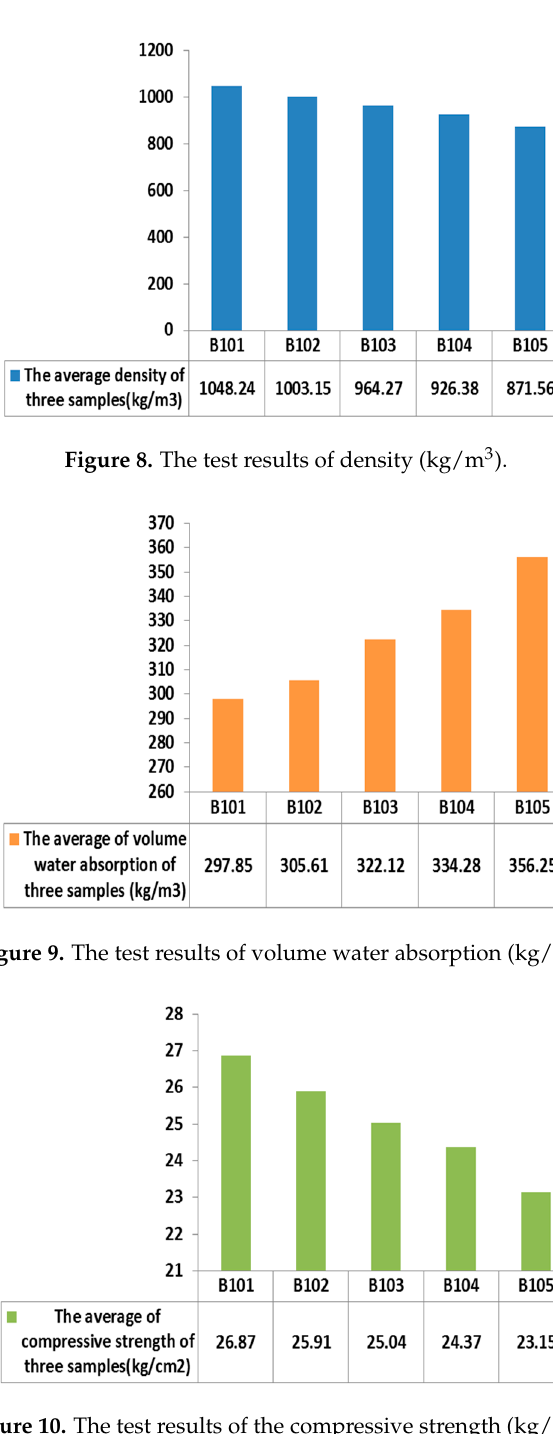
Figure 10. The test results of the compressive strength (kg/cm 2 ).